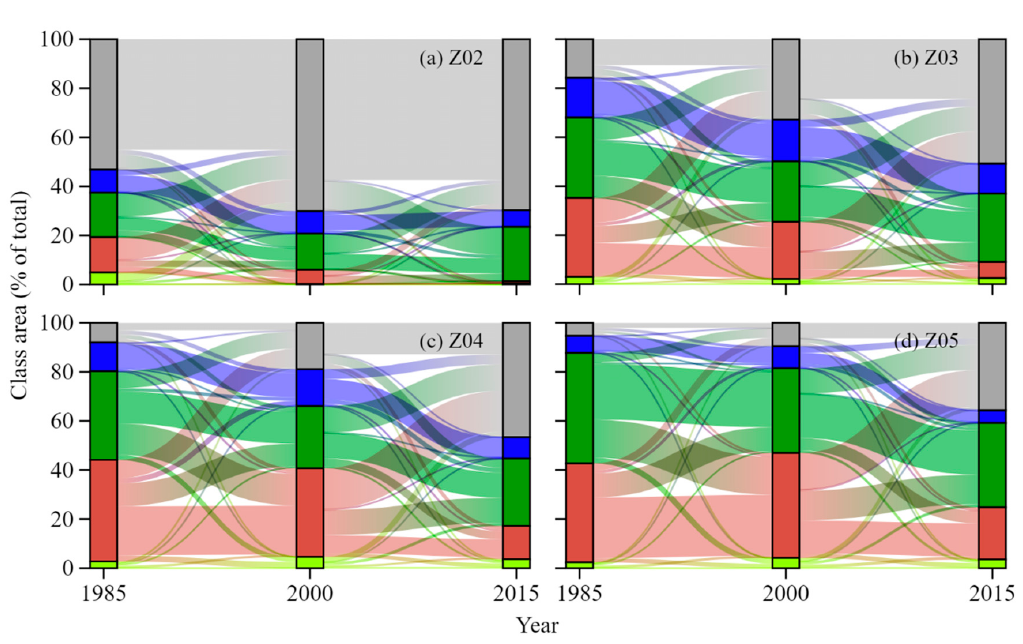
Figure A1. The modified Sankey charts to visualize the state and change flows of LULC for concentric zones (Z02–Z05) in Nanjing from 1985 to 2015.